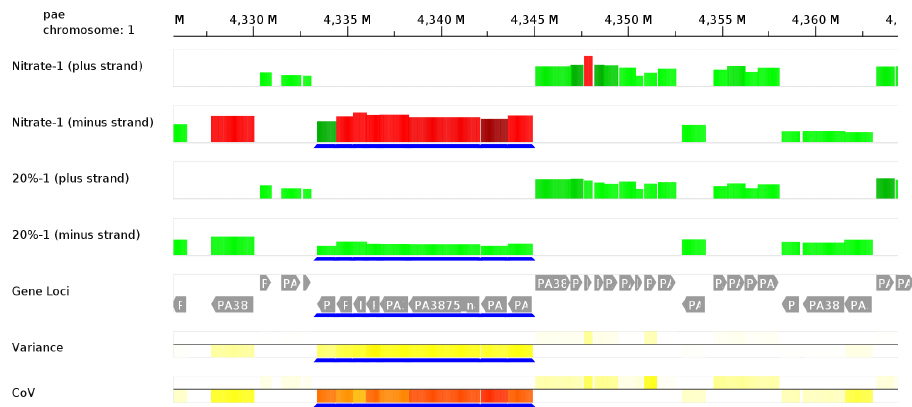
Figure 4: M AYDAY ChromeTracks showing a selected region of the P. aeruginosa chromosome, highlighting a cluster of highly variant probes. Among the visible genes, most genes of the highly variant cluster between 4.335M and 4.345M belong to the nitrogen metabolism and are distinctly highly expressed (fold change > 4 ; data not shown) in the anaerobic